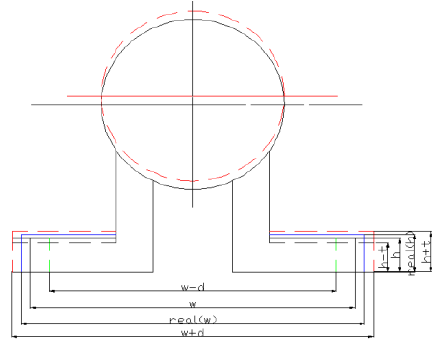
Figure 3 The outline size of